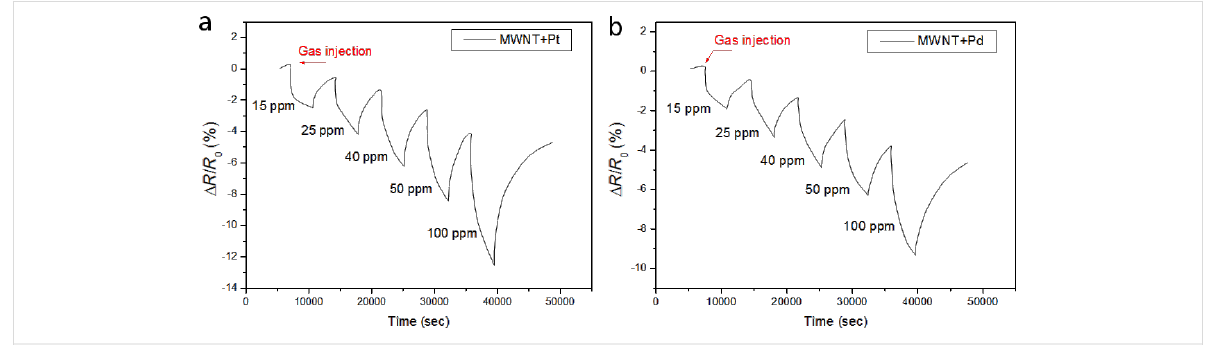
Figure 6: (a) Response of a Pt- decorated MWCNTs sensor to various concentrations of NO 2 . (b) Response of Pd-decorated MWCNTs sensor to various concentrations of NO 2